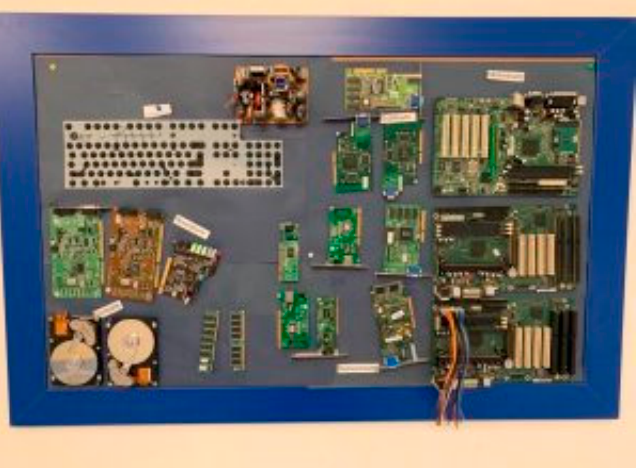
Figure 2. Collage of the computer components investigated after workshop 2. The third workshop was held at the end of January 2020. At the beginning, the focus was on the testing of prototype two. The trigger images were redesigned in color and